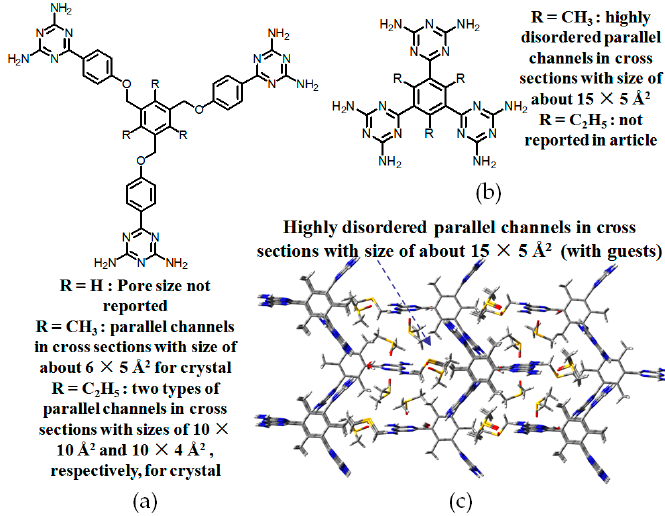
Figure 25. ( a ) Structures of motifs 28a (R = H), 28b (R = CH 3 ), and 28c (R = CH 3 CH 2 ); ( b ) Structures of motif 29a (R = CH 3 ), and 29b (R = CH 3 CH 2 ); ( c ) Top view of H29a grown from DMSO/toluene.